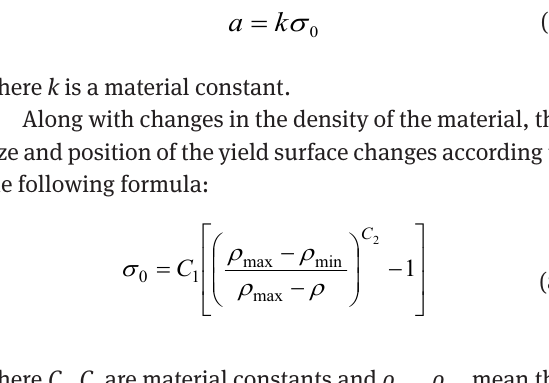
, τ , b) change of ellipse center σ n n